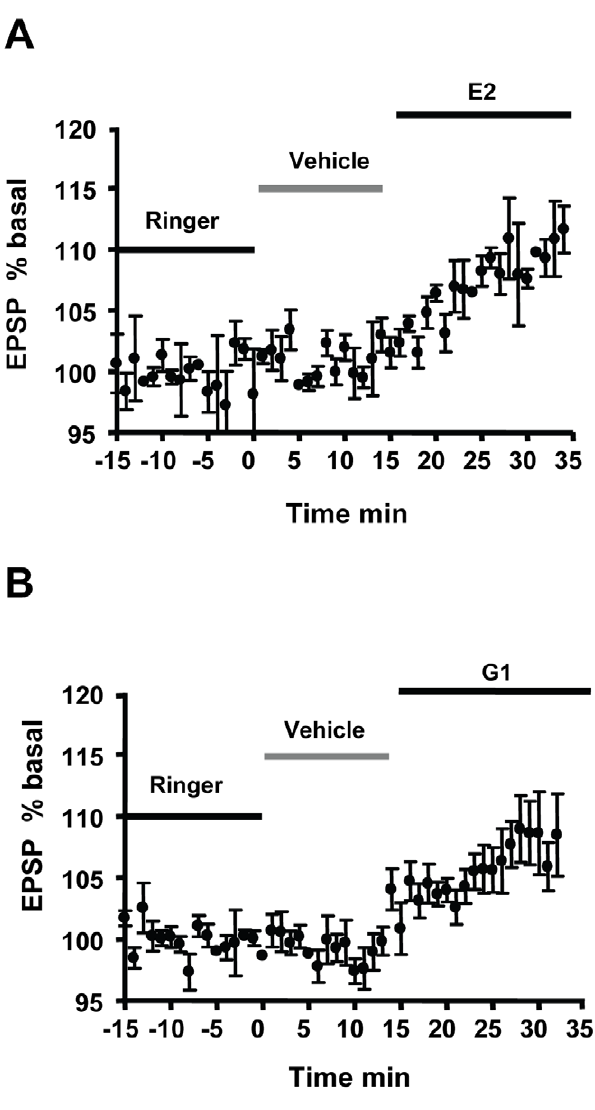
Figure 5. The GPR30 agonist G1 mimics short latency E2 potentiation of hippocampal CA1 neuronal excitability. Chang- es in field EPSPs in response to E2 or G1 were measured on hippocampal slices prepared from OVX young adult female rats. Schaffer collaterals were activated by monopolar stimulation. Slices were perfused with Ringer’s solution until a stable baseline response was obtained. They were then perfused for 15 min with Ringer’s solution containing the vehicle and then with 10 nM E2 (A) or G1 (B). Bins of 1 min were plotted. It was frequently possible to record synaptic activity from more than one slice from the same animal in a recording session. Therefore, to test G1, we recorded from 14 slices originating from 9 different OVX females; of these, 9 exhibited an increase in the fEPSP. Similarly, 8 out of 9 slices from 6 different animals responded to E2. Only responding slices are illustrated in the